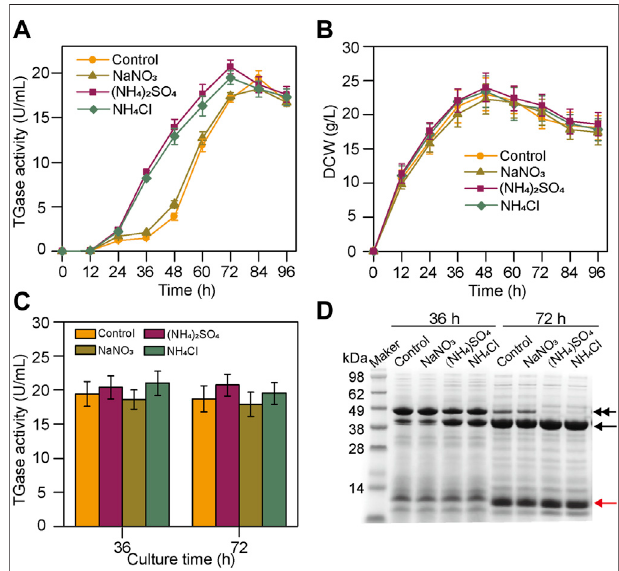
FIGURE1| EffectsofaninorganicnitrogensourceonTGaseproduction by smY 2019. (A) Time course of TGase production with the addition of different inorganic nitrogen sources. (B) Time course of biomass. (C) TGase activity assay after the activation by dispase. (D) SDS-PAGE analysis of the culture supernatants. Thepro-TGase and TGase bandsare indicated with black double and single arrows, respectively. The SSTI bands were identi fi ed using MALDI-TOF/MS (data not shown) and are indicated with red arrows. Each fermentation process was performed in a 250-ml fl ask containing 30 ml of the fermentation medium added with 30 mM of inorganic nitrogen at 30 ° C and 220 rpm. In the control experiment, no inorganic nitrogen source was